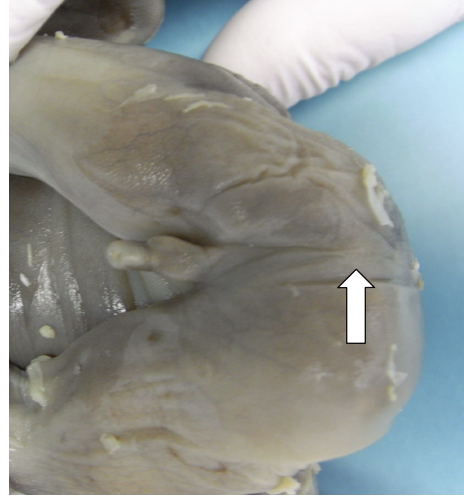
Figure 4: This female fetus showed masculine external genitalia with an imperforate anus